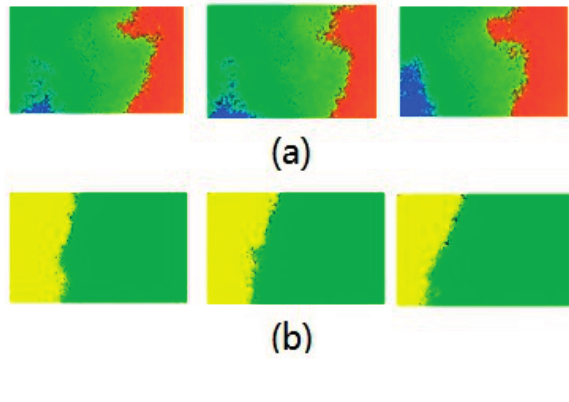
Figure 14. ( a ) The distribution of polarization degree in different time of a day; ( b ) The distribution of polarization angle in different time of a